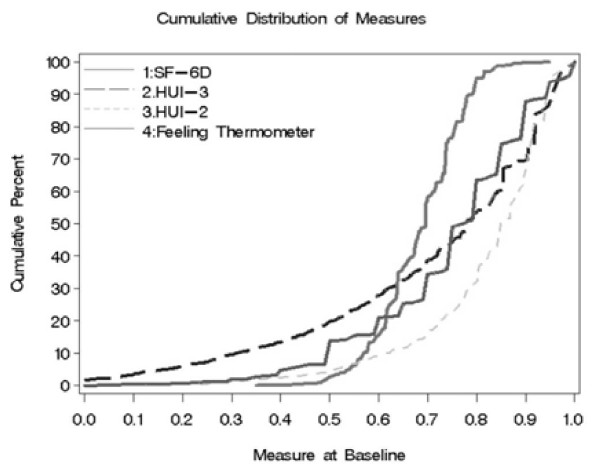
Health utility and feeling thermometer scores by measurement technique, with cumulative distributions.